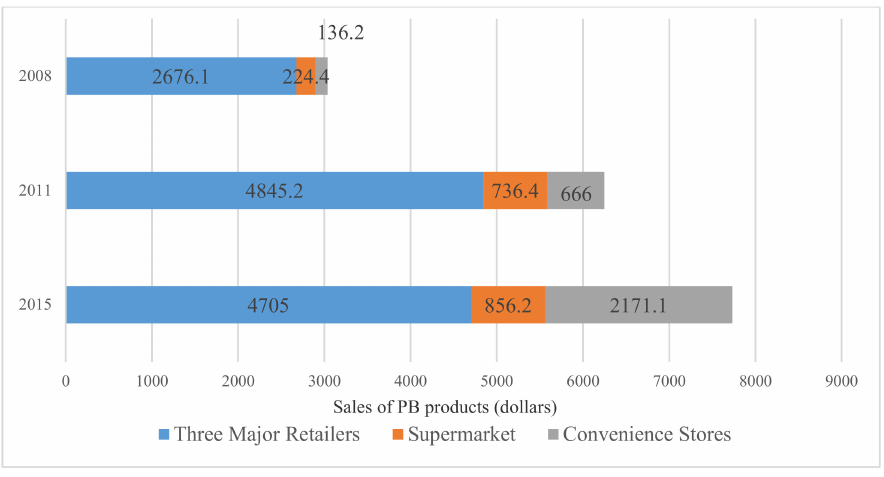
(Unit: millions) Figure 3. Sales of private brand (PB) products from three major retailers, supermarkets, and conve- nience stores (USD). Source: Chosun (2017)